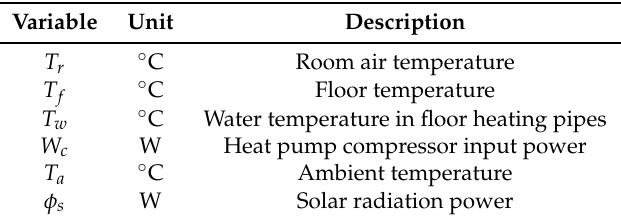
Table 3. Building heating control system variable